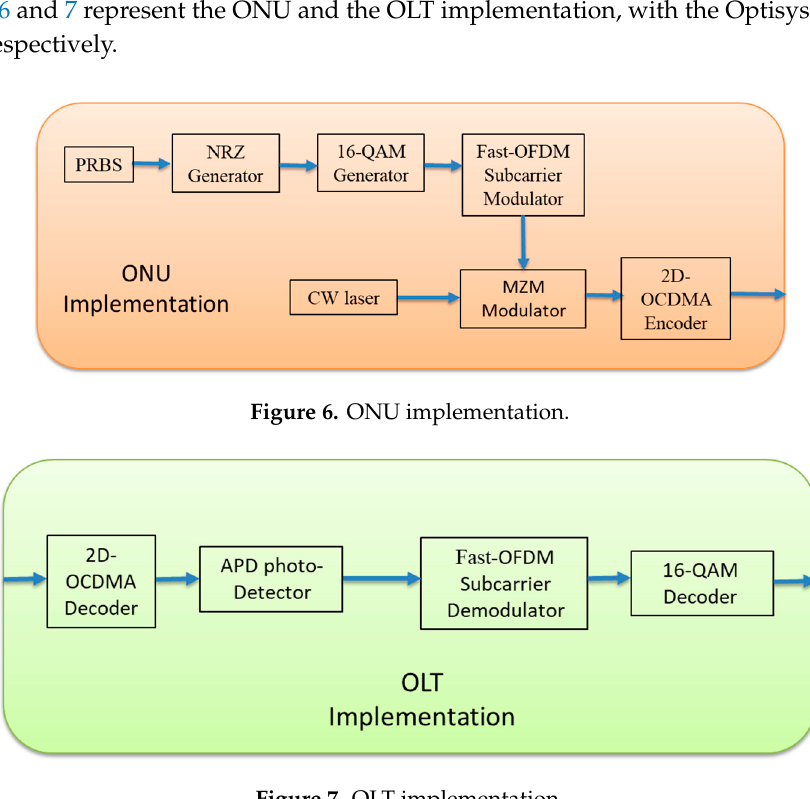
Figure 5. Q-factor versus launched optical power.